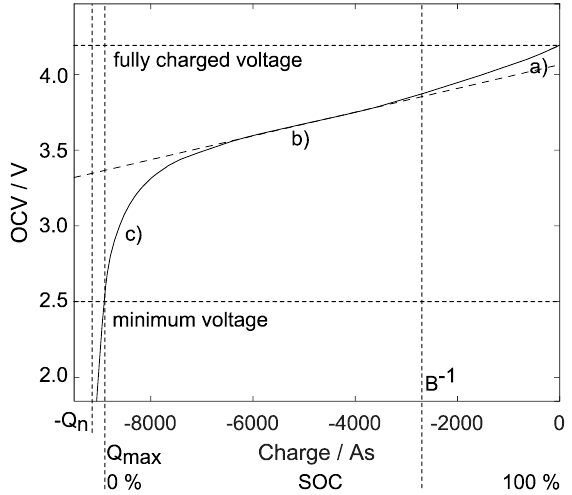
Figure 2. Typical lithium-ion battery open-circuit voltage curve (Example: 2.5 Ah NMC cell; no-load current and in steady-state). Its behavior during discharge contains three phases (right to left): ( a ) initial exponential decline, ( b ) in the middle range a slight decrease, and ( c ) a sharp voltage drop towards its empty state.